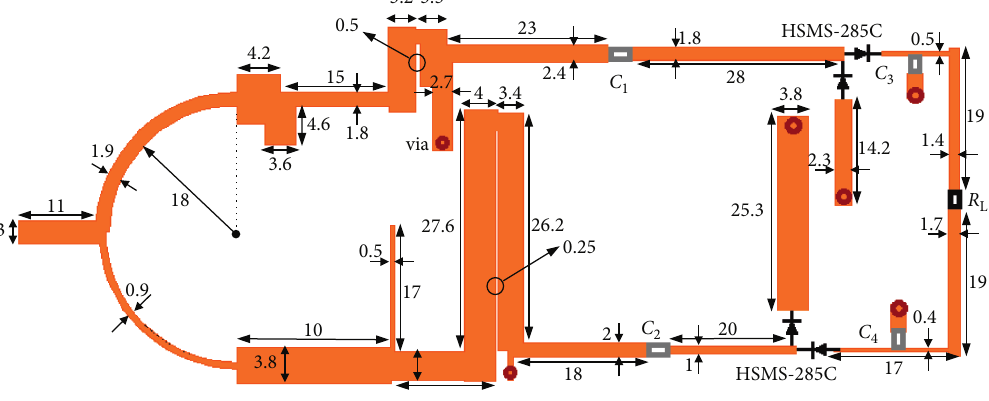
Figure 9: The schematic of the proposed rectifier: C